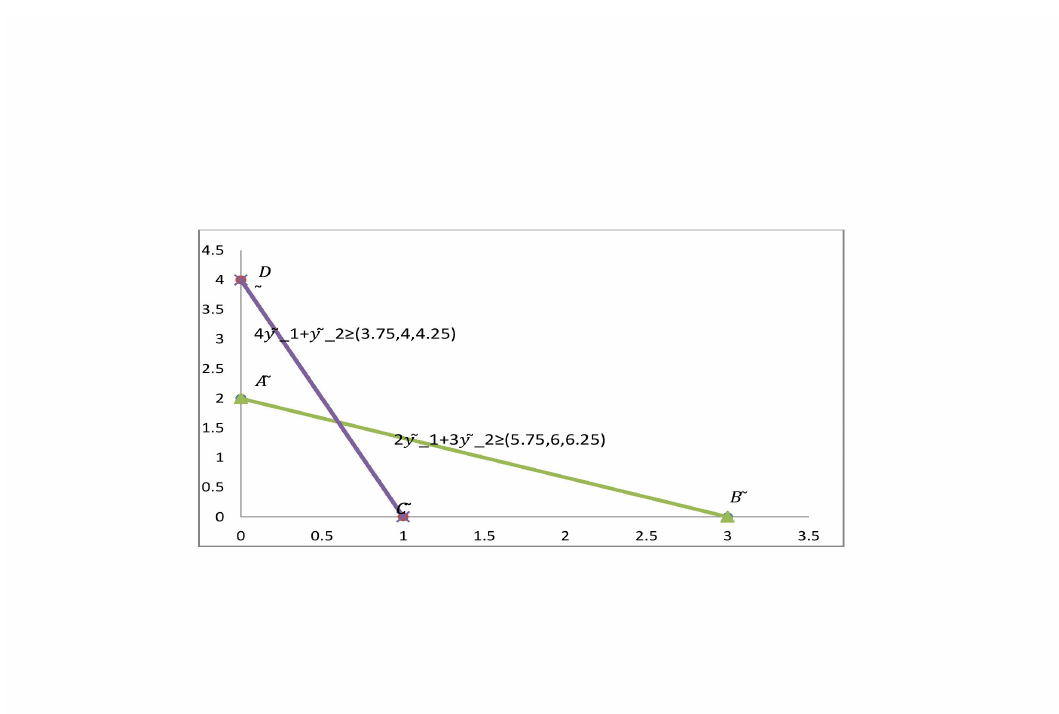
Figure 1: Finding an infeasible solution for primal fuzzy linear programming